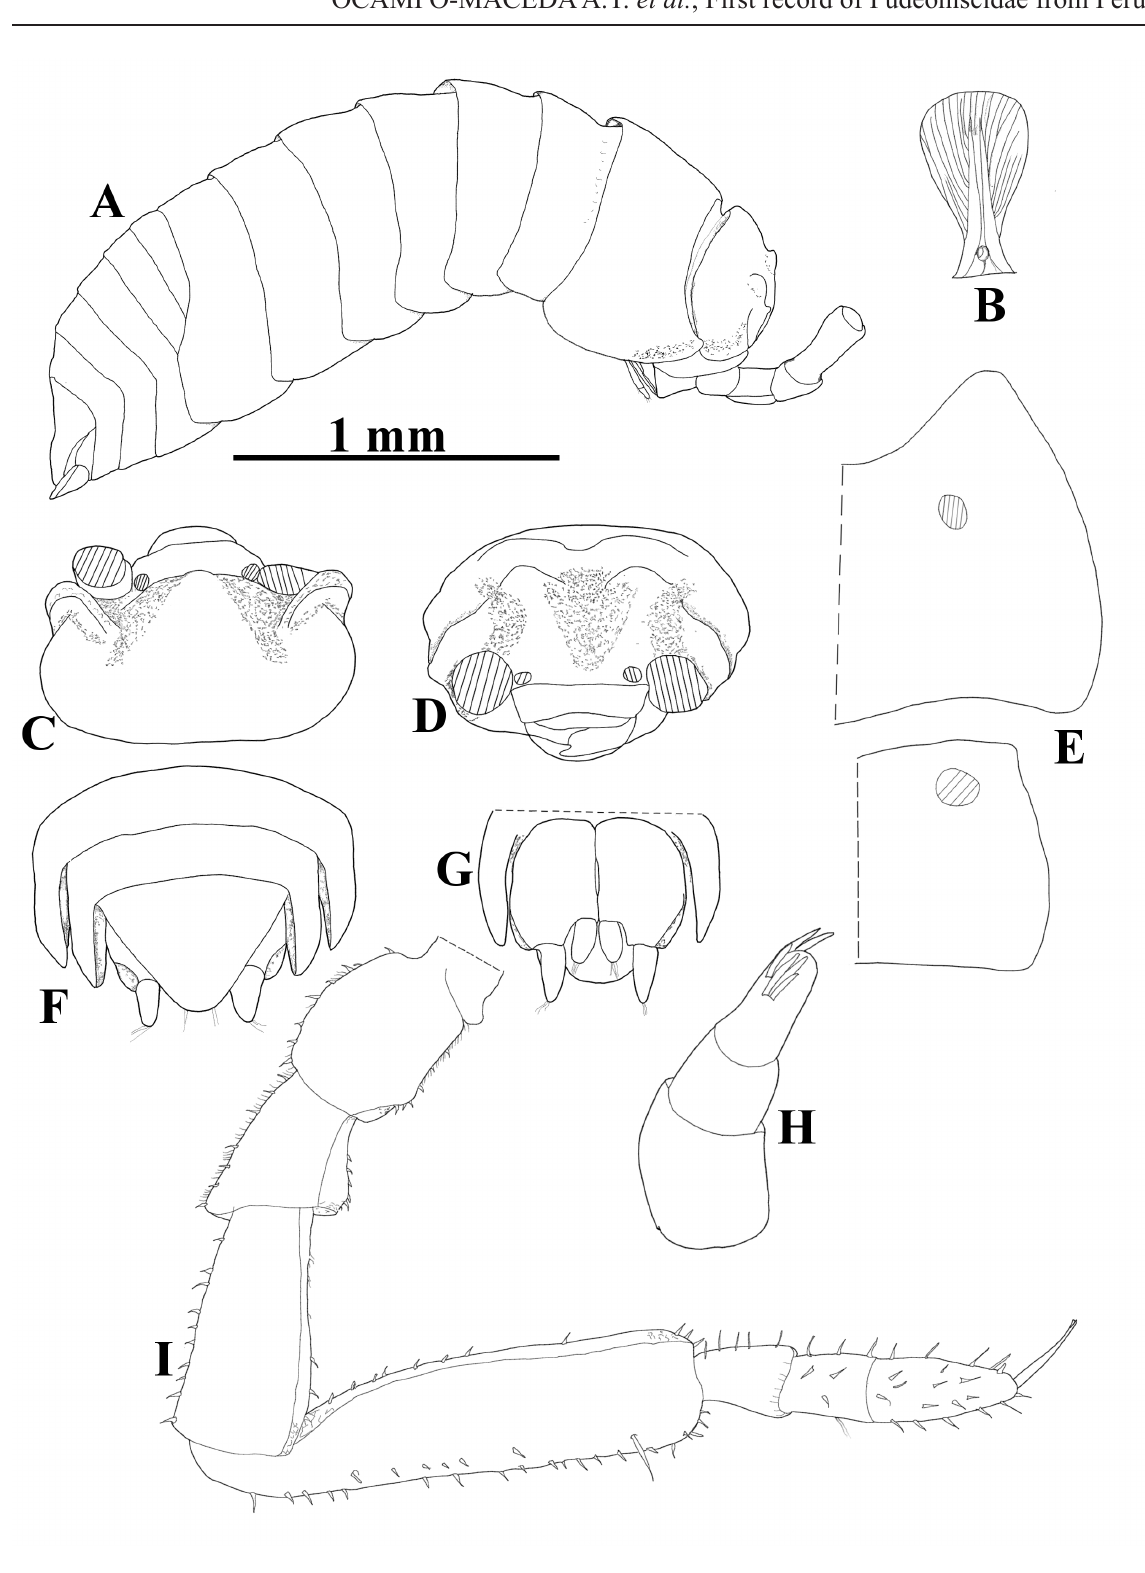
Fig. 1. Loretoniscus mashiriaensis gen. et sp. nov., ♂, holotype (MUSA-ENT-ISO 025). A . Habitus, lateral view. B . Dorsal scale-seta. C . Cephalon, dorsal view. D . Cephalon, frontal view. E . Pereonites 1 and 2 epimera, ventral view. F . Pleonites 4, 5, telson and uropods, dorsal view. G . Pleonite 5 and uropods, ventral view. H . Antennula. I .